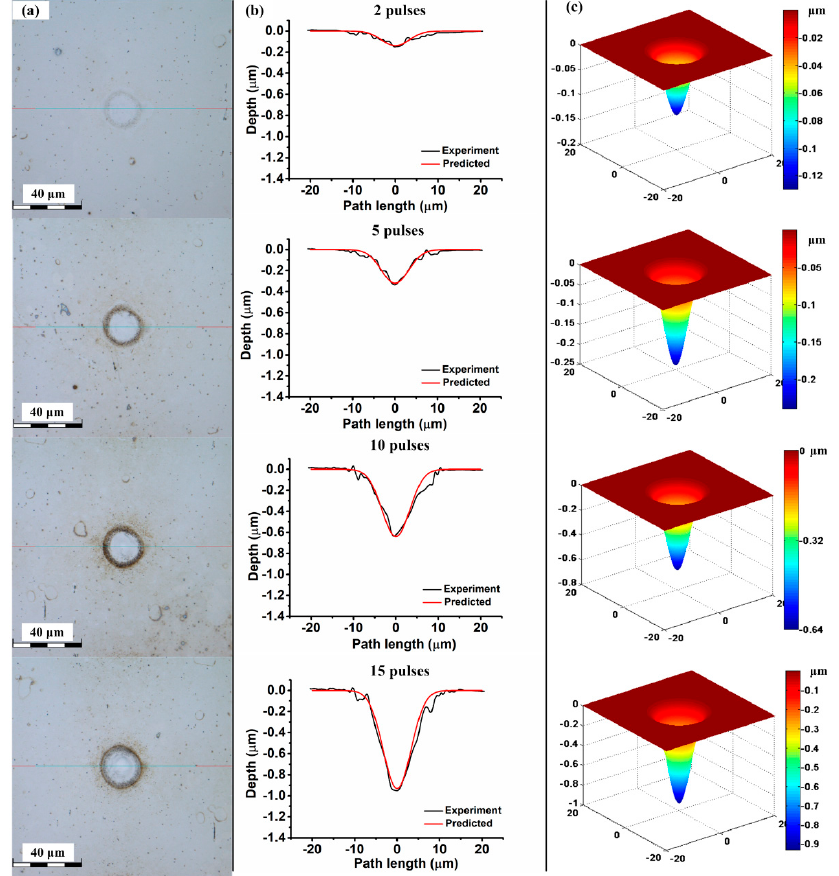
Figure 4. Comparison between experimental and predicted micro-craters for different pulses: ( a ) measured micro-craters, ( b ) comparison of cross-sectional profiles, and ( c ) predicted micro-craters.